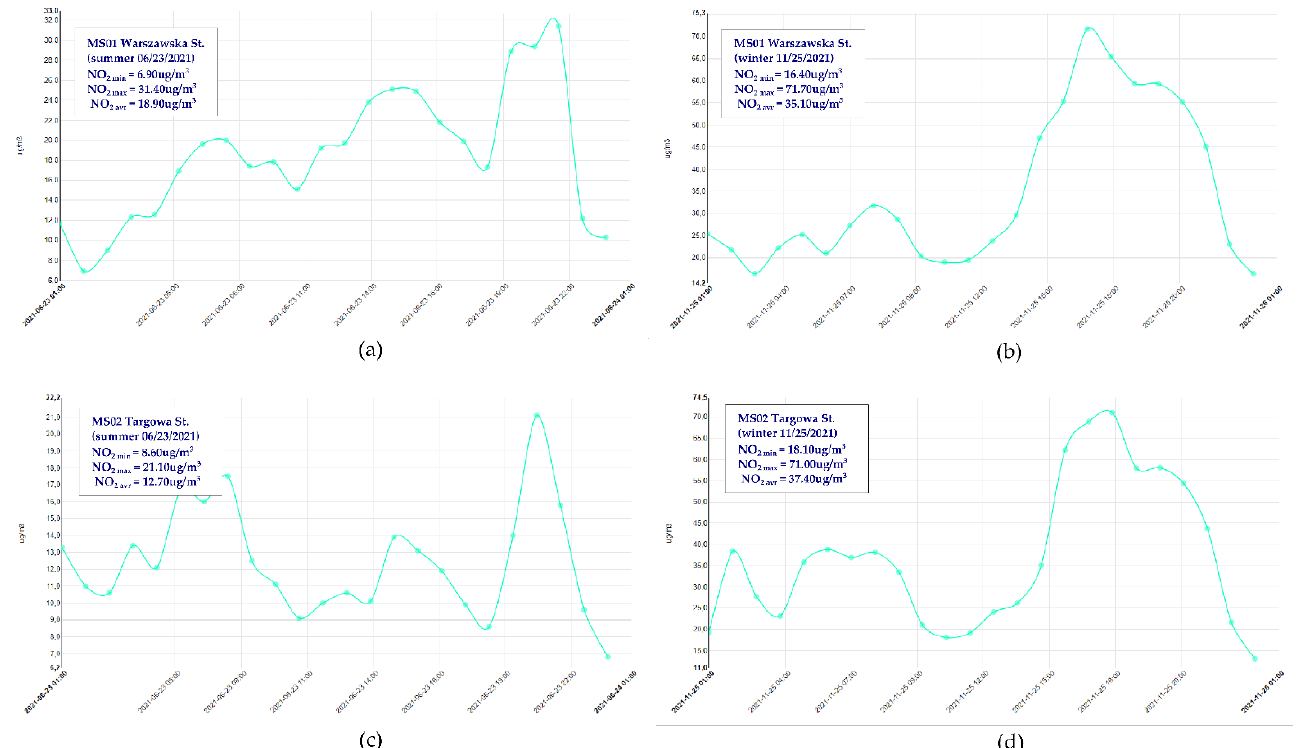
Figure 12. Daily measurement of the NO 2 level at the air monitoring stations in Kielce: ( a ) station MS01 Warszawska St.—summer season; ( b ) station MS01 Warszawska St.—winter season; ( c ) station MS02 Targowa St.—summer season; ( d ) station MS02 Targowa St.—winter season.